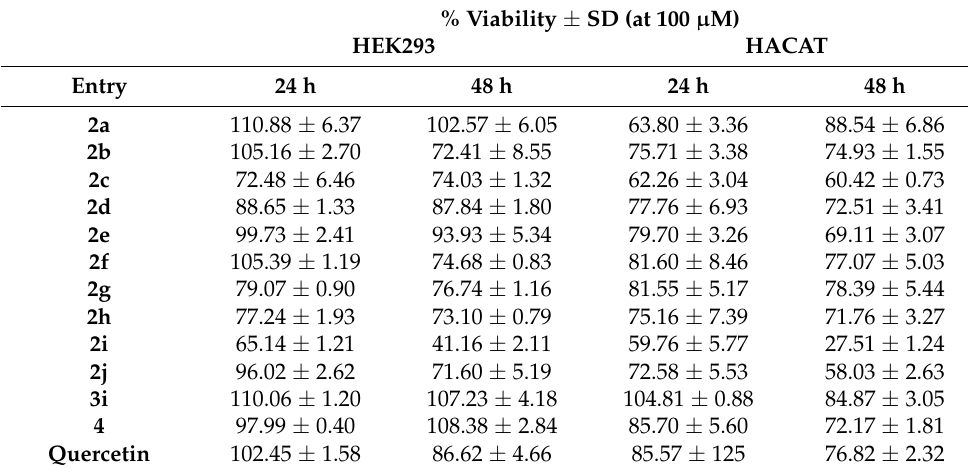
Table 2. The percentage of viability HEK293 cell and HACAT cell affected by synthesized compounds at 100 µ M.